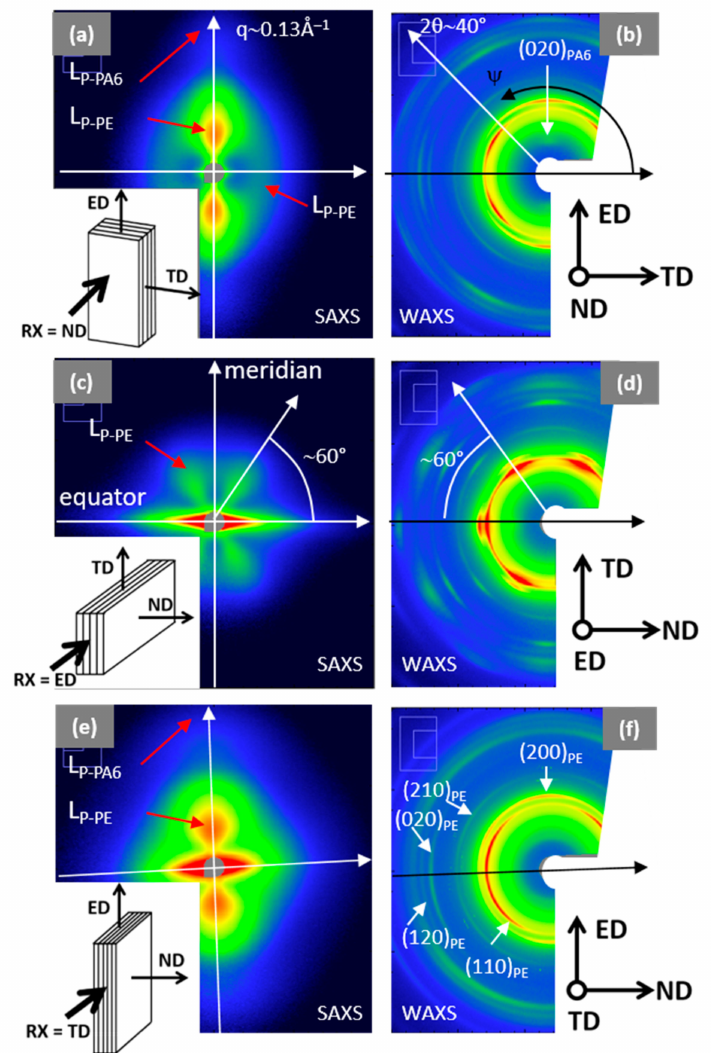
Figure 5. 2D SAXS (on left) and WAXS (on right) patterns of 8 LME PE/PEgMA/PA6 multilayer films in ( a – b ): normal (ND), in ( c – d ): extrusion (ED), ( e – f ): transverse (TD) direction. The q range in SAXS is 0.01 to 0.13 Å − 1 , the 2 θ range in WAXS is 5 to 40 ◦